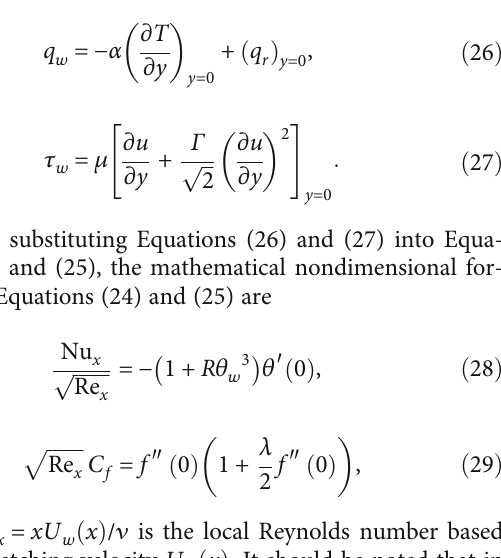
Figure 1: The velocity pro fi le for di ff erent values of M .